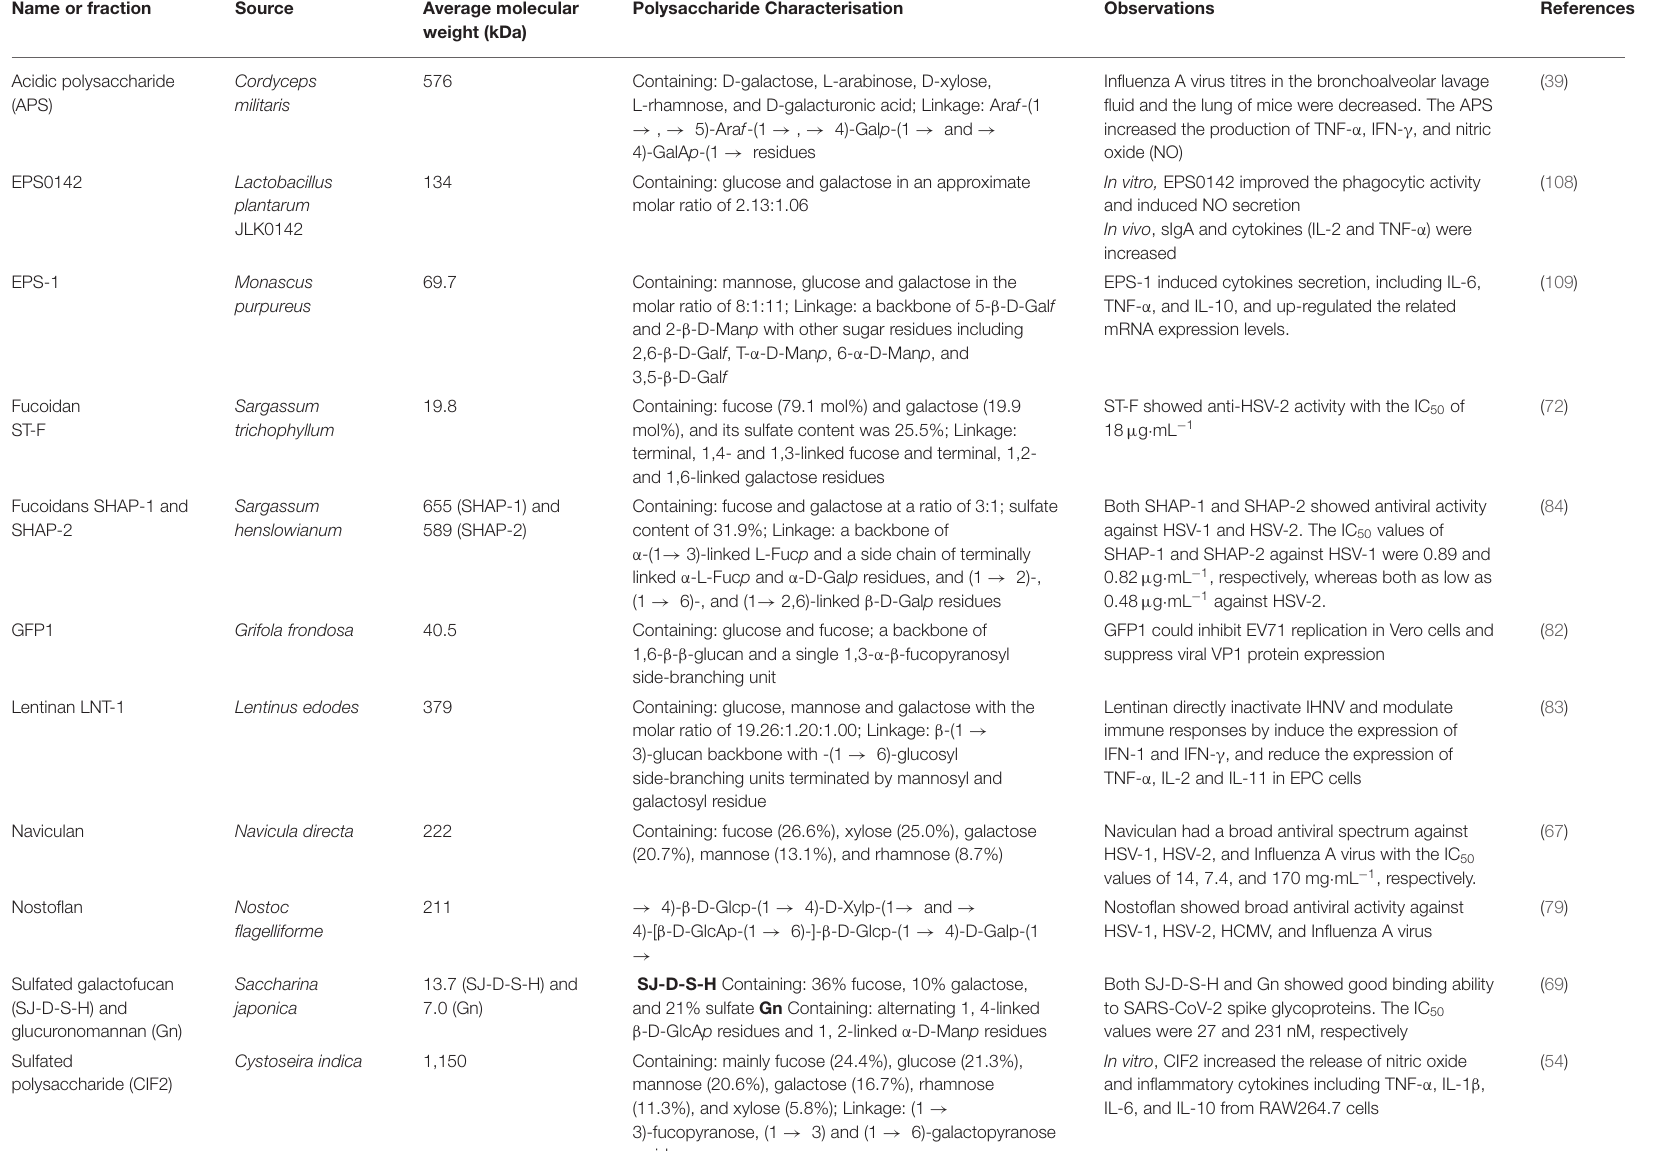
TABLE 2 | Some microbial polysaccharides from various sources with different characteristics and